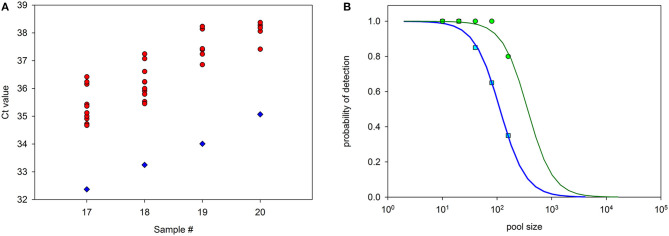
Probability of detection of samples included in pools of different sizes. Samples #17 to #20, which possessed the highest Ct values, were diluted 1:20 with negative samples and measured. (A) Diamonds: Original Ct (ORF1) from samples #17 to #20. Circles: Ct values from 10 replicates of the same samples diluted 1:20 with negative samples and measured. Detection with Ct <40 was positive in all dilutions of samples #17 and #18, 7 out of 10 dilutions of sample #19, and 5 out of 10 dilutions of sample #20 (circles with the same Ct value appear superimposed). (B) Probability of detection, as determined in 20 replicas as before, for pools containing one positive sample of Ct = 31.7 (ORF1) diluted at 1:10 to 1:160 with negative samples. Blue squares: ORF1 gene. Green circles: N gene. Lines are best fits of sensitivity curves.